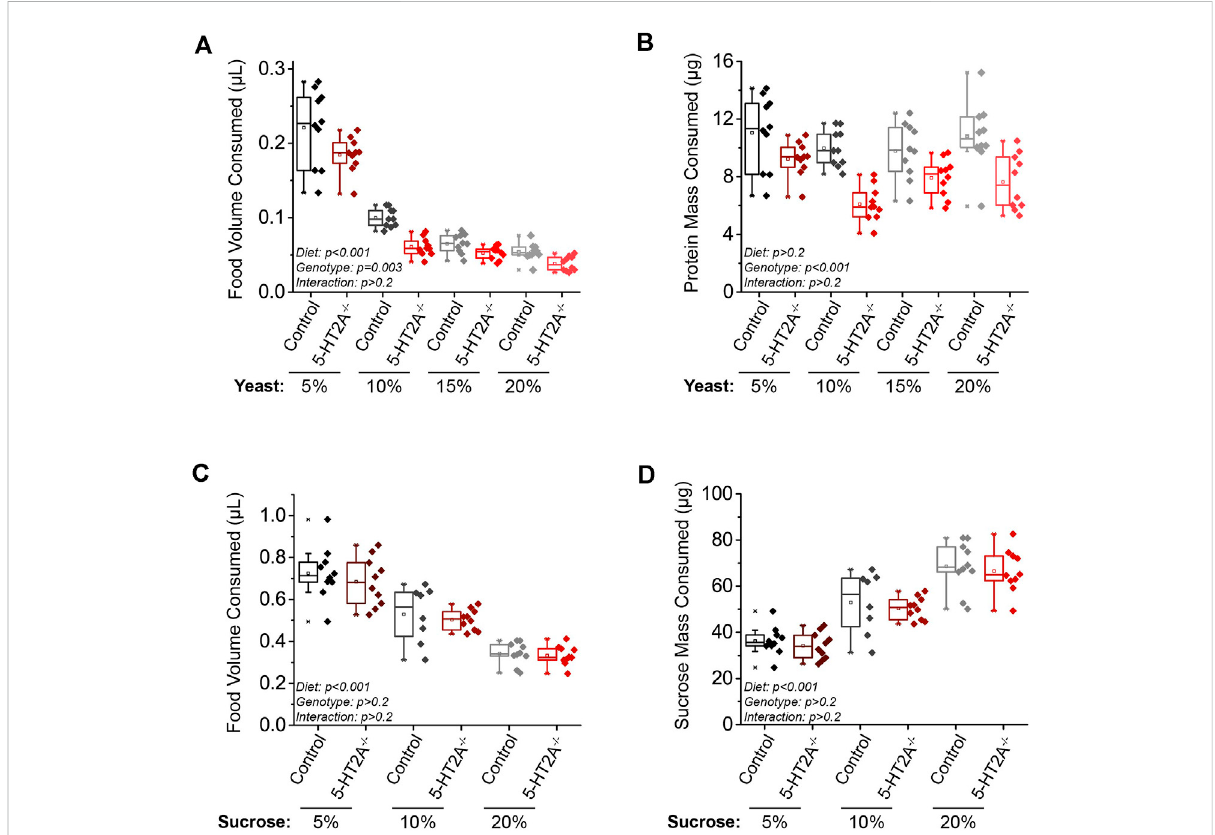
FIGURE 2 5-HT2A modulates the protein consumption set-point. (A) As dietary yeast increases, both 5-HT2A − / − mutants and w-; CS controls consume less ( n = 10 where each replicate is comprisedof 10 fl ies, ANCOVA Diet: p < 0.001 Genotype: p = 0.003 Interaction: p = 0.242), and whenthese data arescaledtorepresentthemassofproteinconsumedacrossdiets, (B) 5-HT2A − / − mutantsshowadecreasedproteinconsumptiontargetacrossdiets ( n = 10 whereeach replicate is comprised of 10 fl ies, ANCOVA Diet: p = 0.322 Genotype: p < 0.001 Interaction: p = 0.605). Relative to controls, 5-HT2A − / − mutantsshow no differences from controls in the (C) total volume ( n = 8 – 10 where eachreplicate iscomprisedof 10 fl ies, ANCOVA Diet: p < 0.001 Genotype: p = 0.263 Interaction: p =0.594) or (D) massofsucroseconsumedacross three different concentrations ofasucrose-only diet ( n = 8 – 10 where each replicate is comprised of 10 fl ies, ANCOVA Diet: p < 0.001 Genotype: p = 0.409 Interaction: p = 0.996). All experiments were conducted in